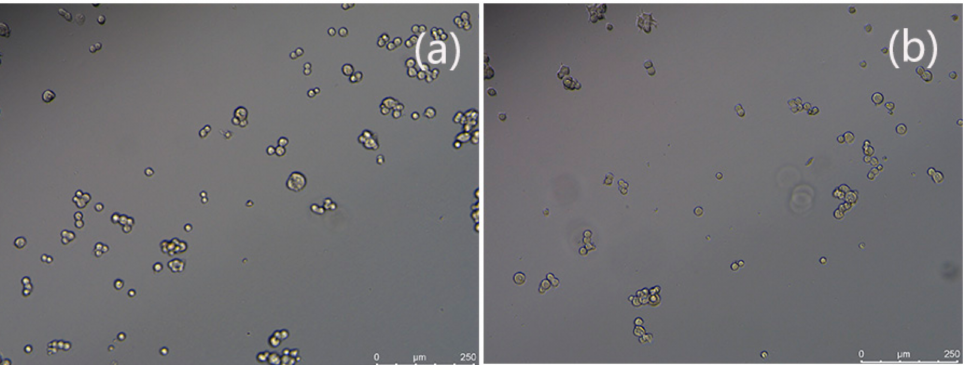
Figure 7. Optical images of NIH3T3 responses P-CH dressing with di ff erent concentration of PHGH (wt %) ( a ) reference cell culture and ( b ) P-CH after 24 h using MTT